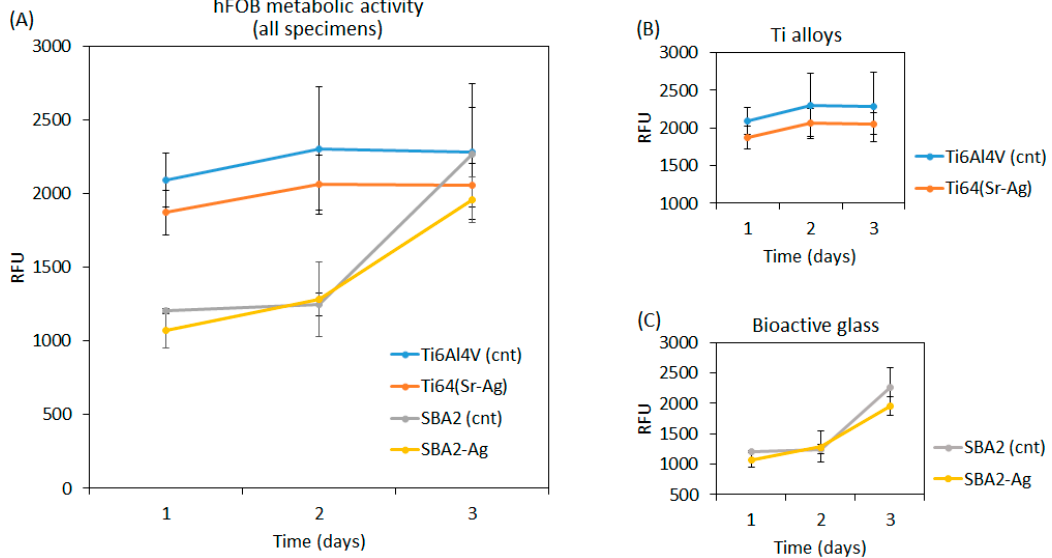
Figure 5. Evaluation of cytocompatibility of both the raw (cnt) and doped (Ag) specimens. In general ( A ), no statistically significant differences were noticed in the cells metabolism ( p > 0.05) in detail, nor for the Ti alloy ( B ) nor bioactive glass ( C ) the Ag-doping determined toxicity.